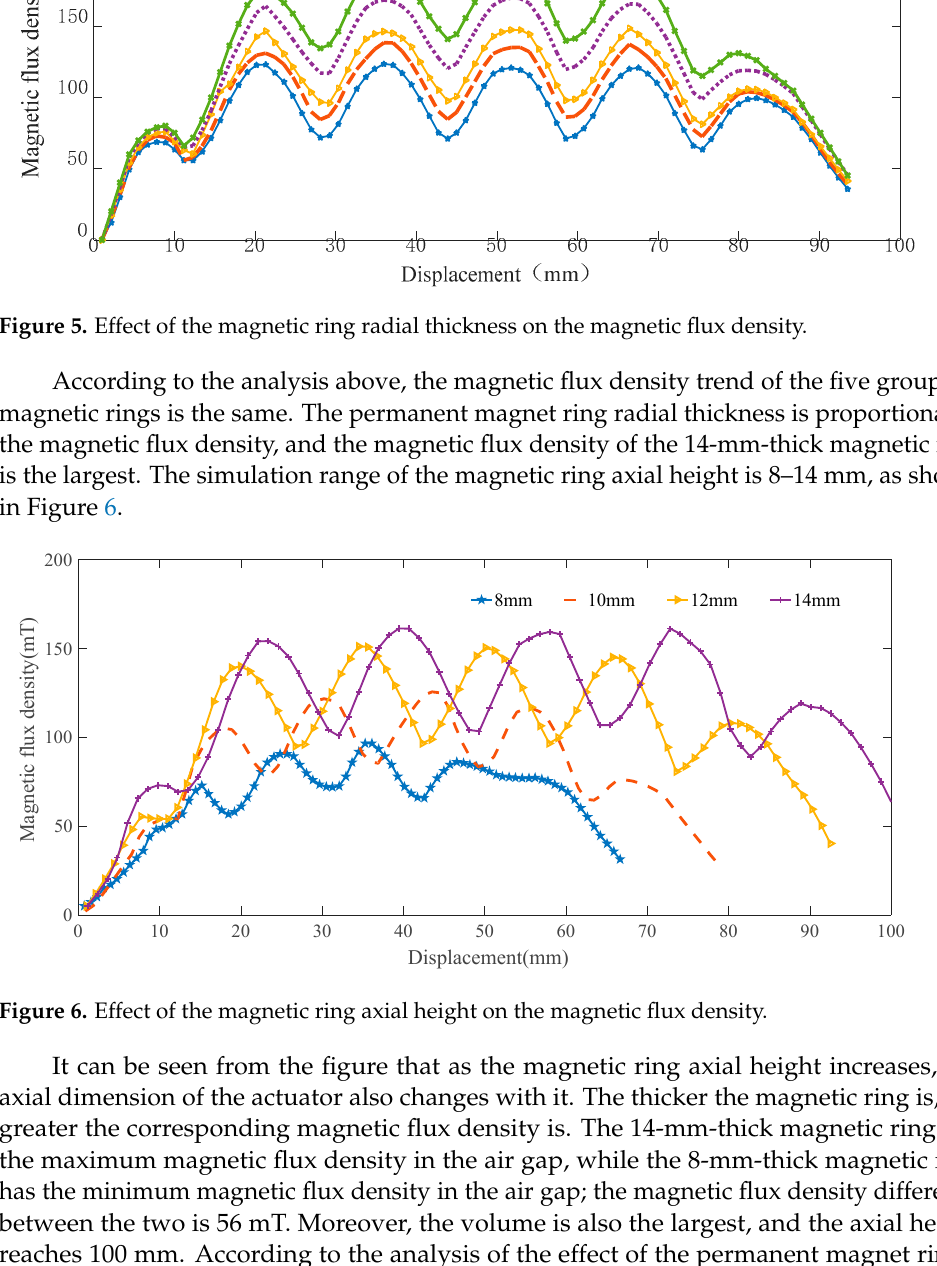
Figure 5. Effect of the magnetic ring radial thickness on the magnetic flux density.